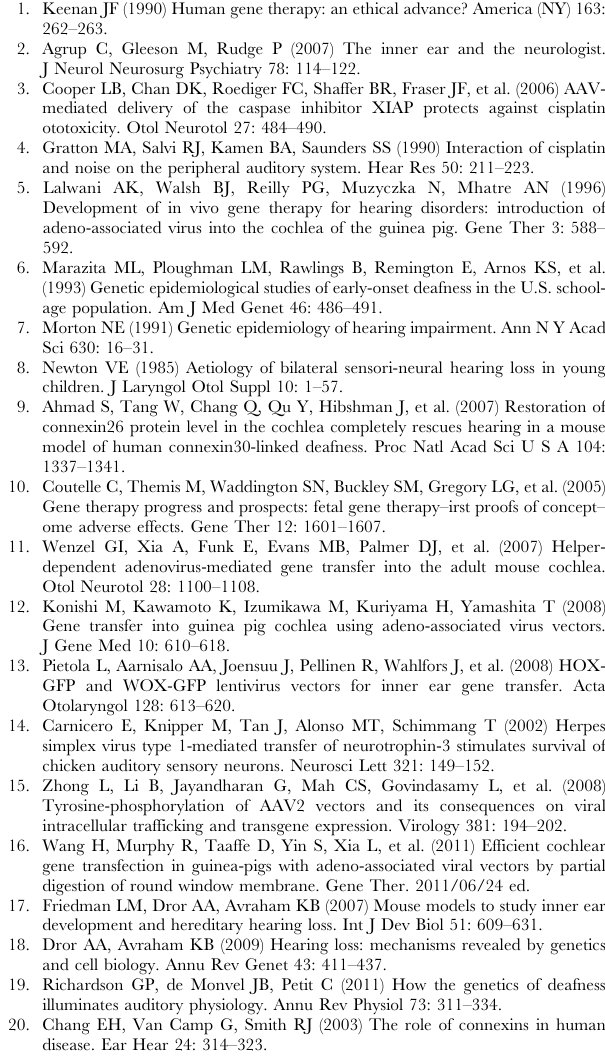
Figure S1 Comparison of AAV-mediated inner ear transfection in neonatal mice and adult guinea